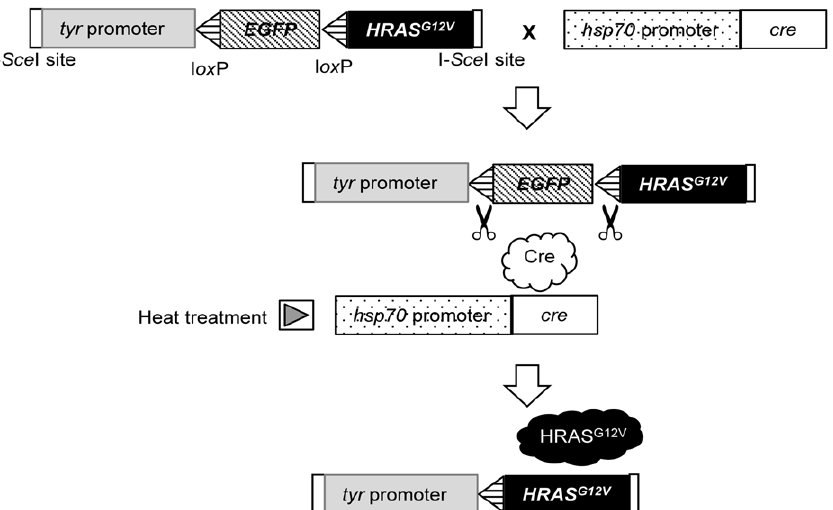
Figure 1. Generation of transgenic medaka expressing human HRAS G12V . A plasmid containing the human HRAS G12V cDNA downstream of the medaka tyrosinase gene ( tyr ) promoter as well as the EGFP gene positioned between loxP sequences was constructed for the generation of transgenic medaka. These transgenic fish were crossed with another transgenic line harboring the gene for Cre recombinase ( cre ) under the control of the medaka hsp70 promoter. The resulting double-transgenic animals express Cre recombinase after exposure to heat shock, resulting in excision of the EGFP gene and expression of HRAS G12V .